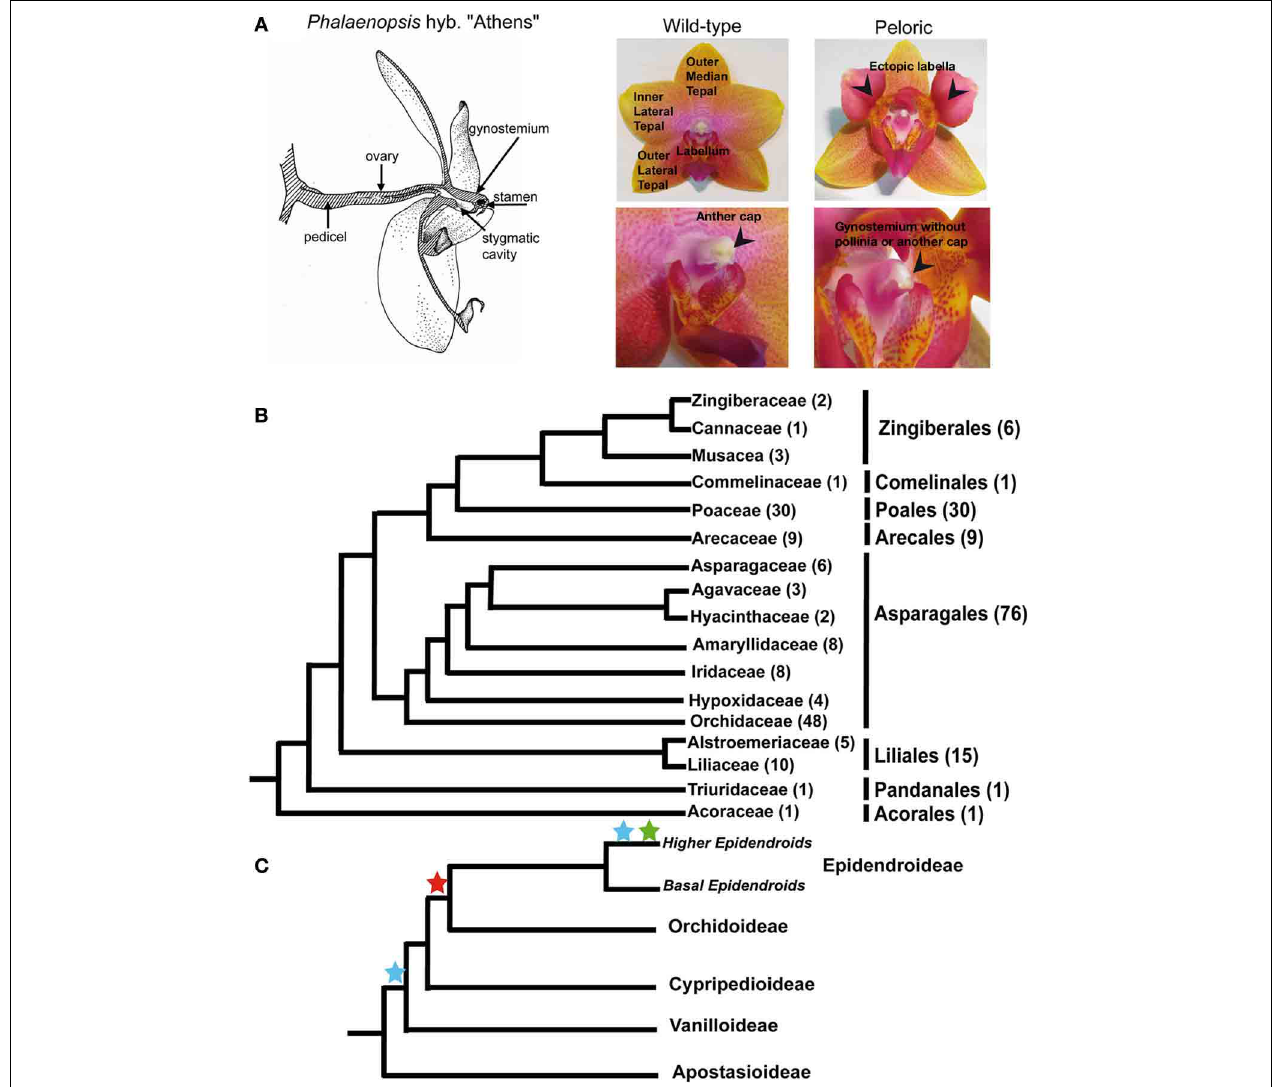
FIGURE 1 | Phalaenopsis flower structure, distinctive floral features of wild-type and peloric hybrid “Athens.” Phylogenetic relationships the sequences studied. (A) Flower organs of wild-type and peloric mutant represented in the analysis. The stamen is located under the anther cap, a whitelaminarstructureontopofthewild-typegynostemium(indicatedwithan arrow). The labella developing in place of inner lateral tepals as well as the organs missing in the gynostemium of peloric flowers are indicated with arrows. (B) Systematic relationships of the plant families represented in the